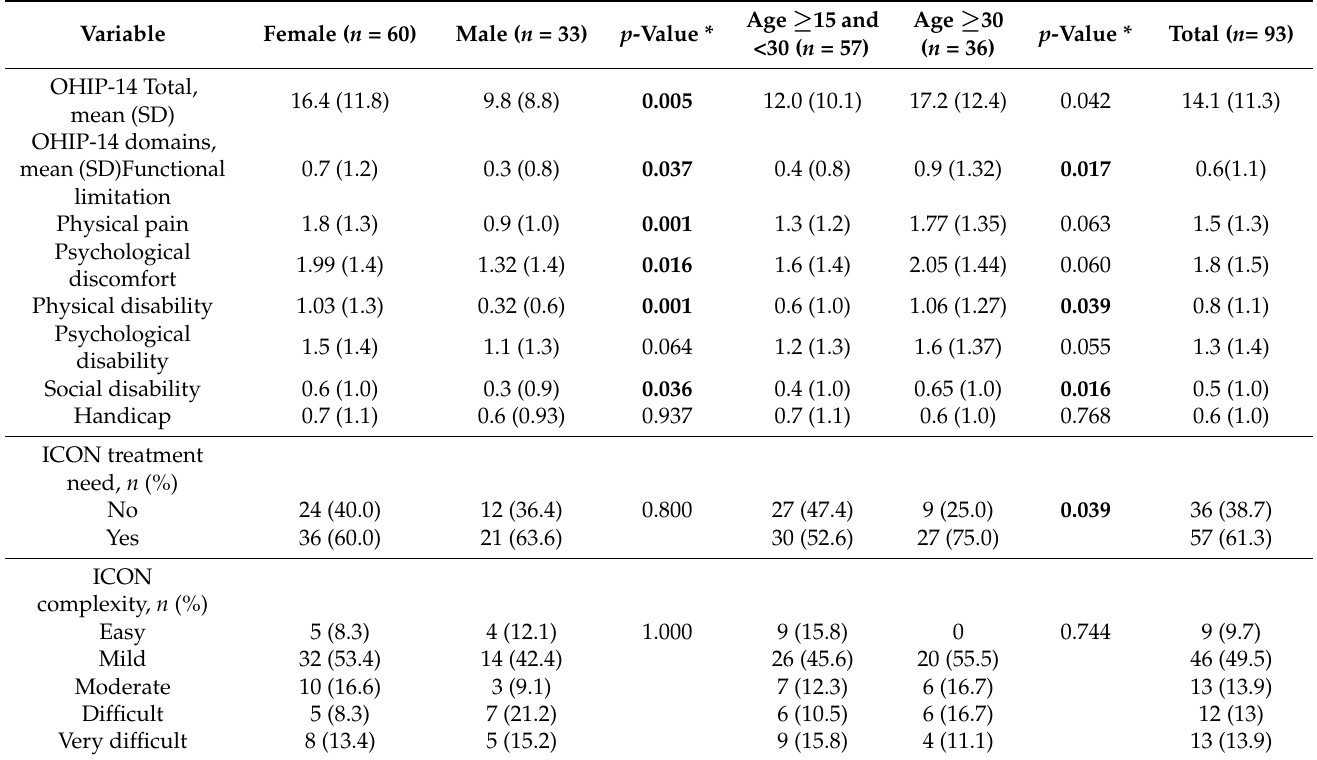
Table 2. OHIP-14 and ICON, according to sex and age and for overall participants ( N = 93).